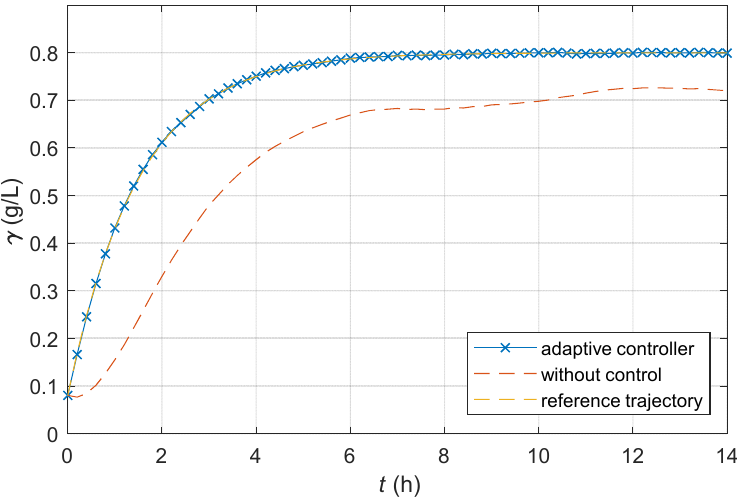
Figure 7. Time course of the dissolved CO 2 concentration γ of the laboratory batch bioreactor with an AMFC system; additionally, time courses of the CO 2 concentration of the reference model and non-controlled laboratory bioreactor are presented for comparison.